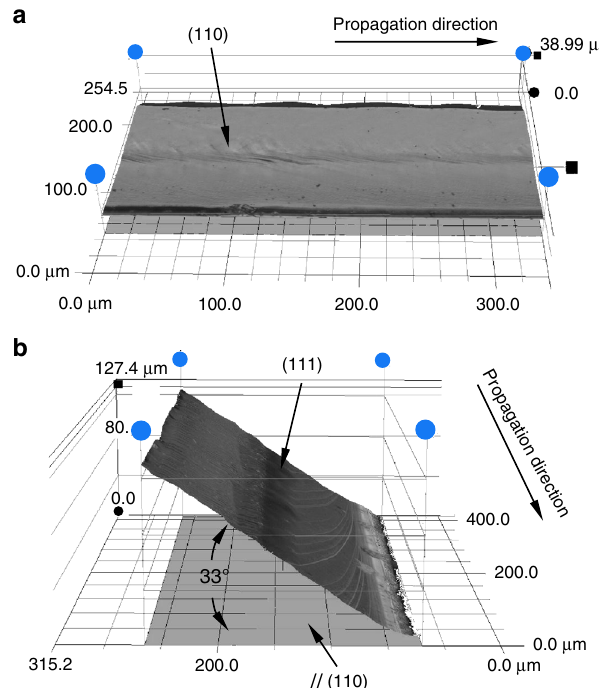
Fig. 2 Crack surface topography for the fast crack that propagated at 3600 m/s. a Primary crack that initiates from the pre-crack. b Secondary crack after deviating underneath the punch roller